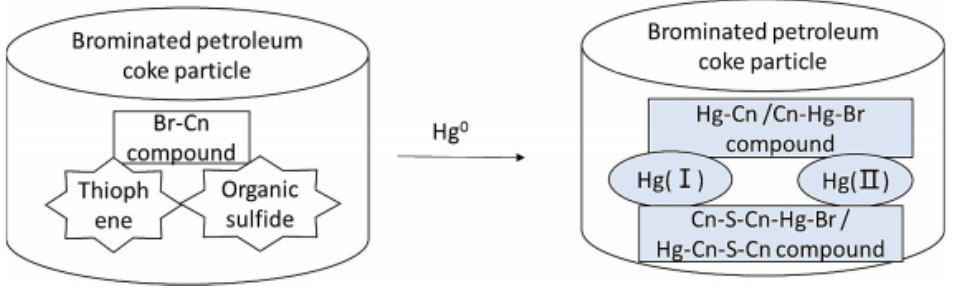
Figure 7. Diagram illustrating mechanism of Hg 0 absorption on brominated petroleum coke surface [46]. Reprinted/adapted with permission from Ref. [46]. 2017, Carbon.